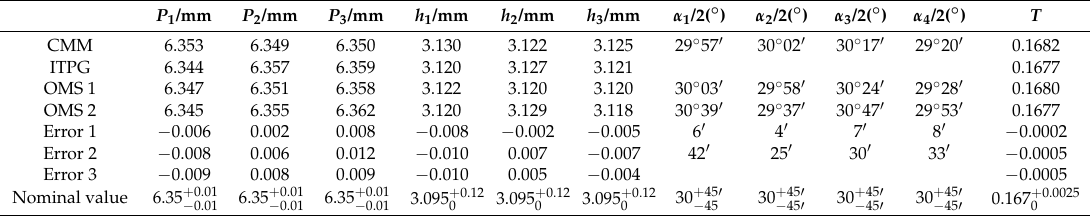
Figure 16. Contour fitting and partial enlarged drawing. ( a ) The contour data after fitting; ( b ) partial enlarged drawing of thread inter diameter section. Table 3. Comparison of the three measuring